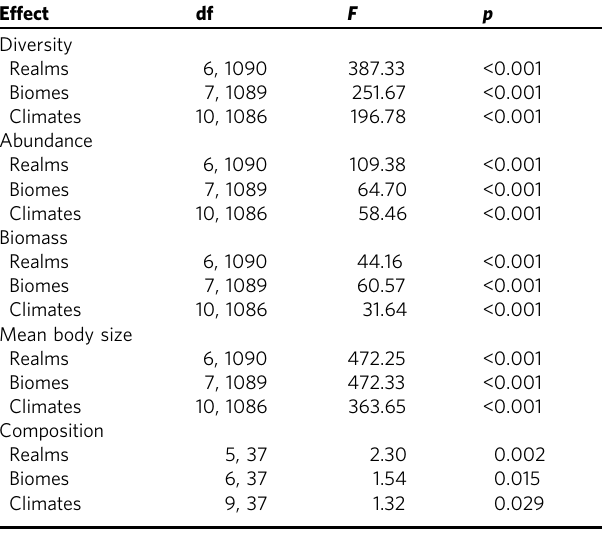
Table 2 Results of linear mixed effects models exploring variation in detritivore and total invertebrate diversity, abundance, biomass and mean body size, and PERMANOVAs exploring variation in assemblage composition, among realms, biomes and climates.